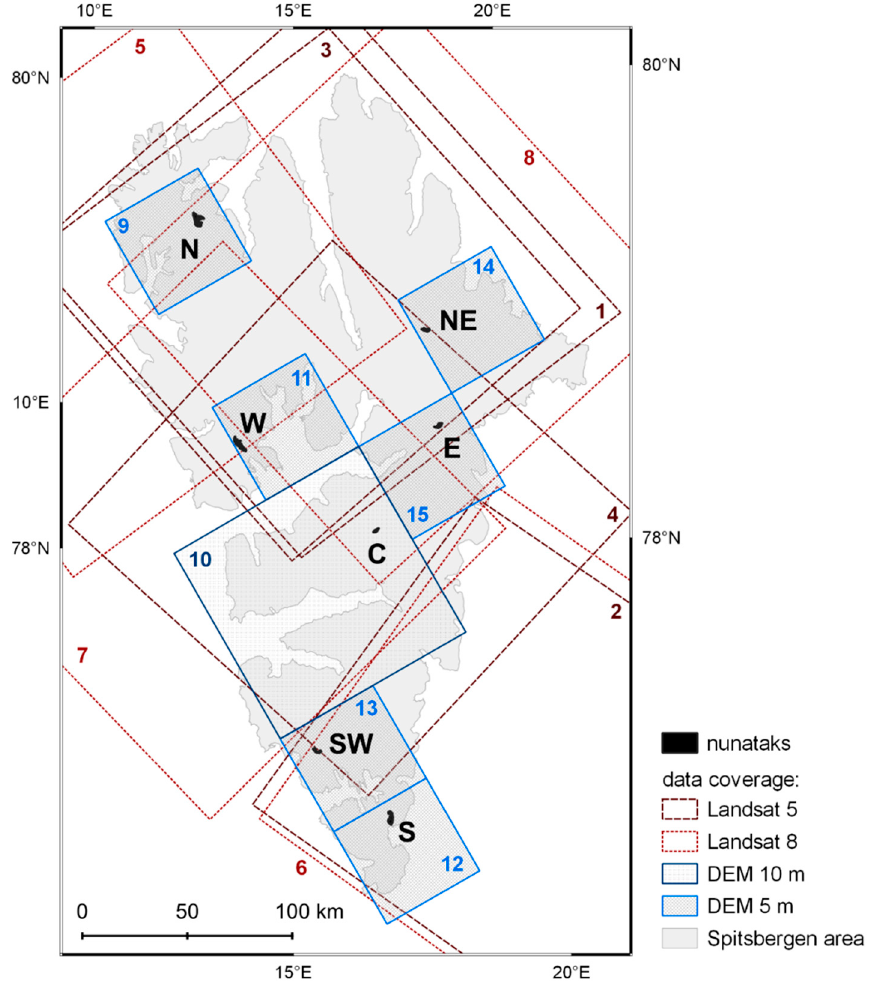
Figure 2. Area covered by the present study: region E — Malte Brunfjellet; region NE — southern part of Č ernyševfjellet; region S — Pulkovofjella; region N — Schivefjellet; region W — Kaosfjellet; region SW — Kverven; region C — Drøntoppen. The number labelling is explained in Table 1. Table 1. Landsat satellite scenes and digital elevation model (DEM) files used in the analysis including the source material used in Figure 2.